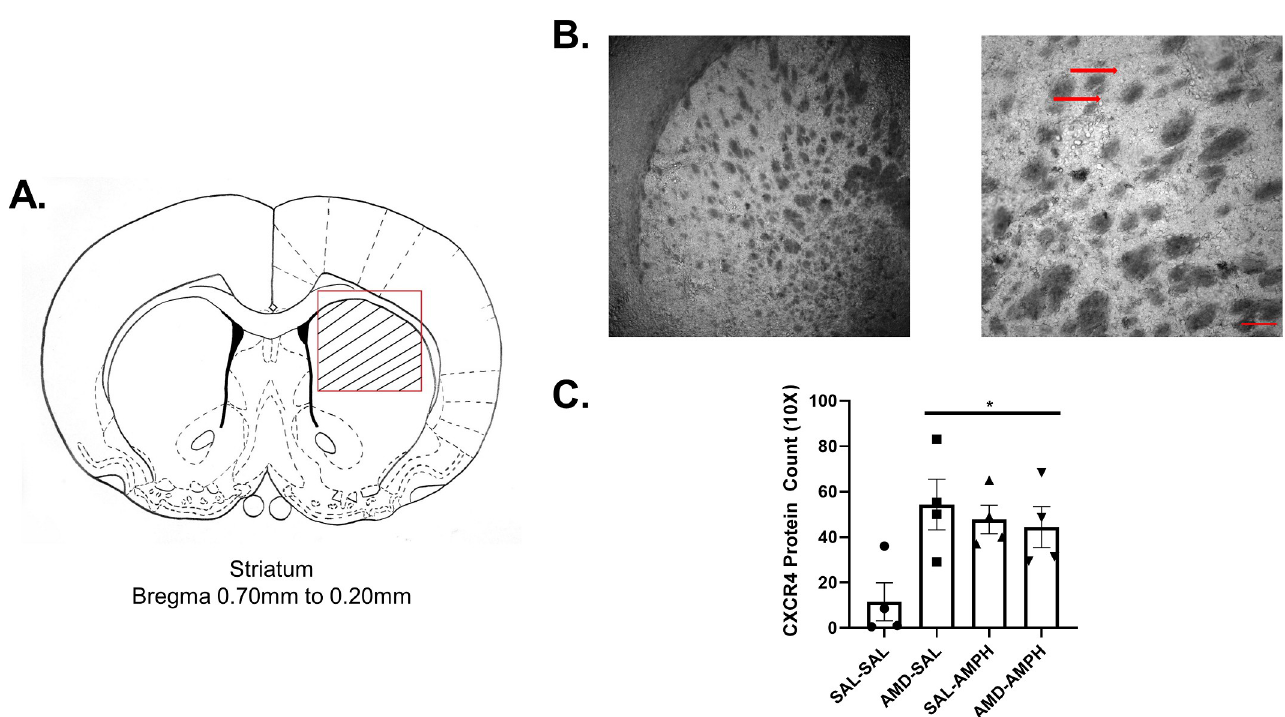
Fig 7. Repeated administration of the CXCR4 antagonist AMD3100 and D-amphetamine sulfate increased CXCR4 protein levels in the dorsomedial striatum. Striatal neurons and glia were visualized with Nickel-DAB after immunostaining for CXCR4, viewed, and imaged on a light microscope (N = 16, n = 4 per group). (A) Cells were counted specifically within the striated targeted region outlined in red on the line drawing, delineating the dorsal striatum. Bregma +0.70 mm to + 0.20 mm ranges were selected based on rat brain atlas coordinates [73]. (B) Sample staining at 4 × magnification and 10 × magnification. The scale bar on the bottom right represents ~240 pixels (154.8 um). The red arrows identify deeply stained striatal puncta and cellular processes. (C) All groups expressed CXCR4 within the dorsal striatum. These numbers were elevated across experimental groups relative to the control (data represented as Mean ± SEM), asterisks ( � ) represent significant differences set at p <